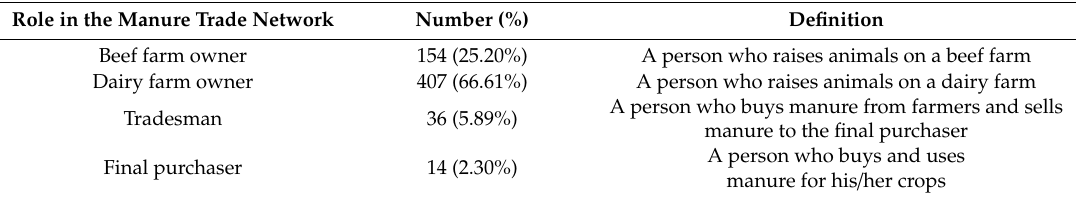
Table 2. Roles of respondents found in the manure trade